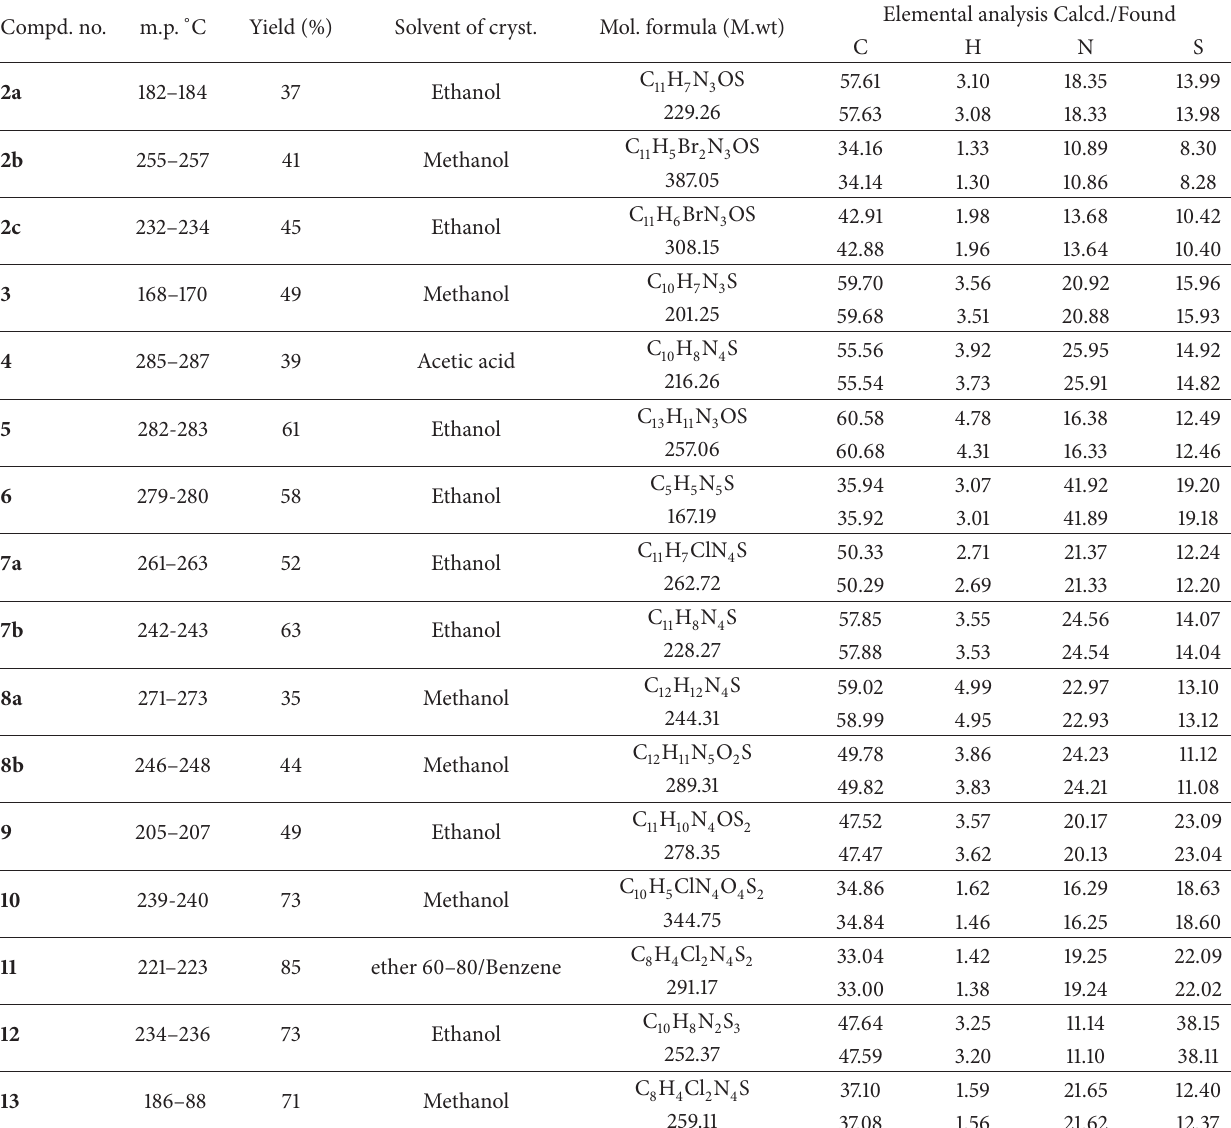
Table 2: Physical properties of the prepared compounds ( 2 – 13 ). Compd.